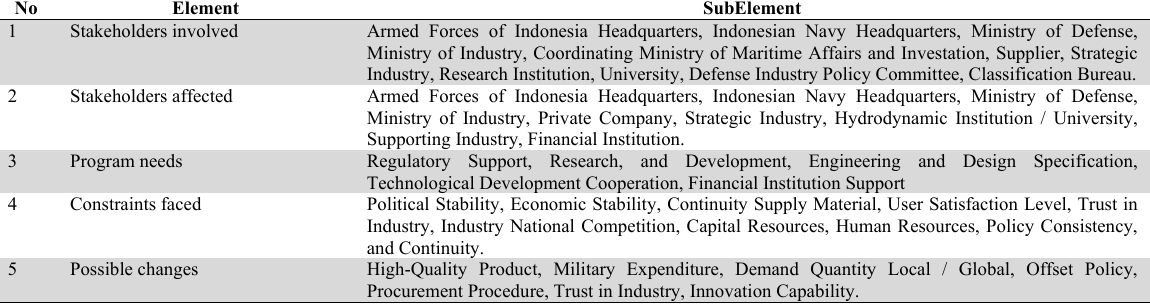
Elements and sub-elements of the institutional